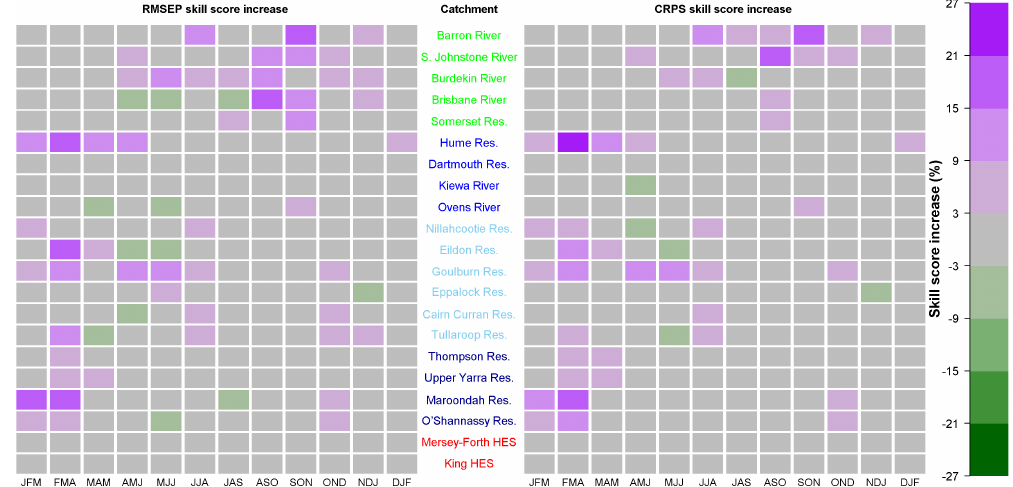
Fig. 11. Increase in skill scores of forecasts achieved by using lag-1 streamflow as well as WAPABA simulations to represent the initial catchment condition.